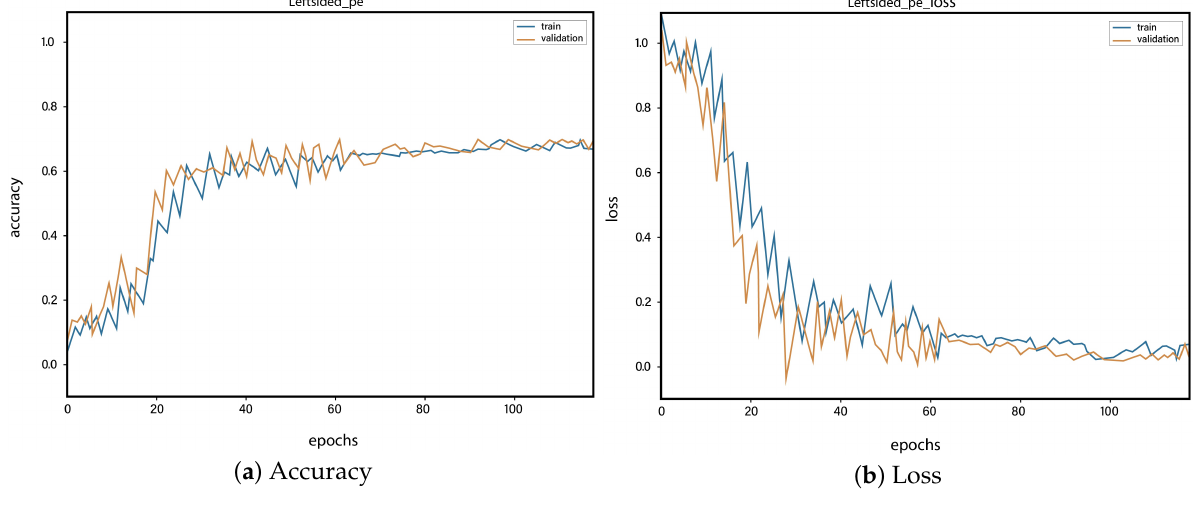
Figure 14. Training vs. validation accuracy and loss for the class: Left-sided PE